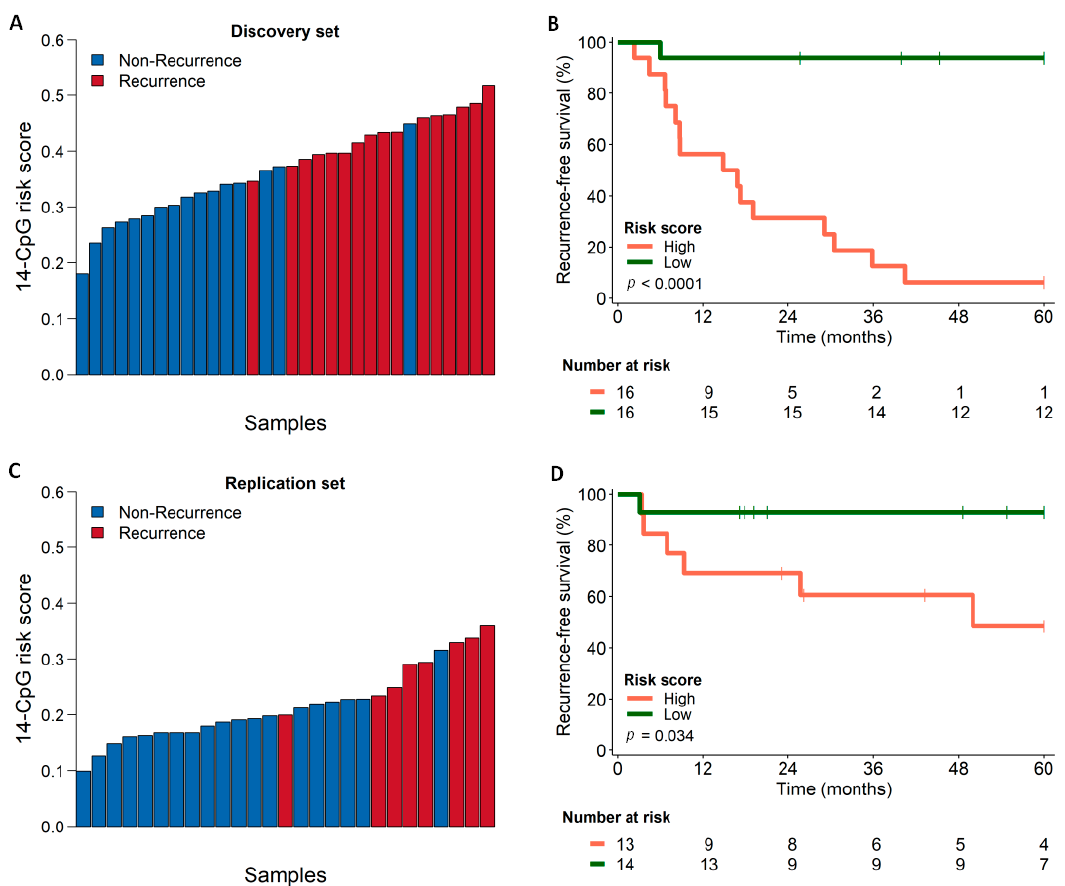
Figure 6. Scoring and survival curves. ( A ) Calculated score for each of the cases from the discovery set using the identified 14-CpG marker; ( B ) Kaplan–Meier curves showing the recurrence-free survival patterns of the cases from the discovery set, comparing cases with low (green line) and high (orange line) risk of developing recurrences; ( C ) scoring for each case from TCGA replication set using the identified 14-CpG marker; ( D ) Kaplan–Meier curves showing the disease-free survival patterns of the cases from the replication set, comparing cases with low (green line) and high (orange line) risk of developing recurrences.